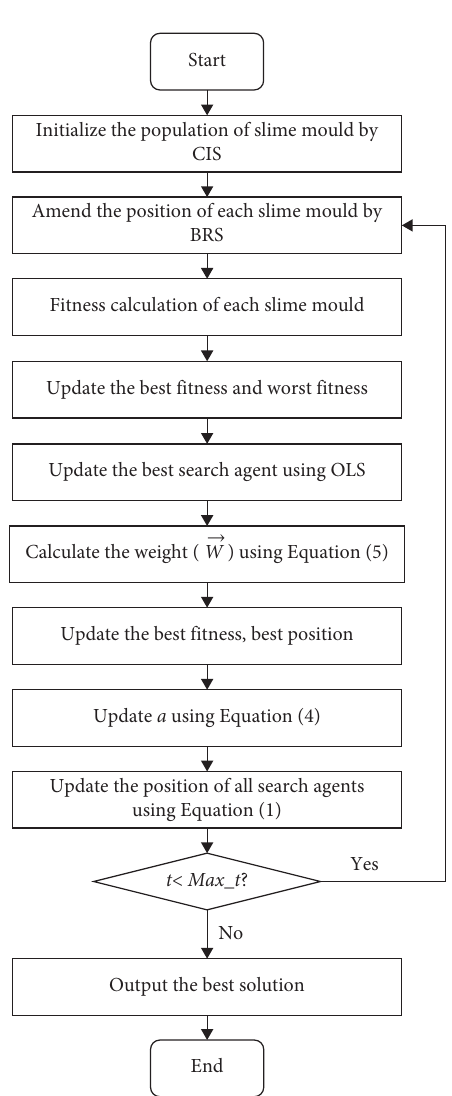
Figure 1: The flowchart of